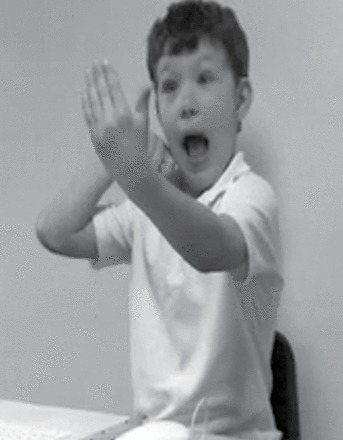
Whole entity constructions with simultaneous CA. The signer’s face represents Wallace (CA) and his hands represent Wallace and the wall (DC).